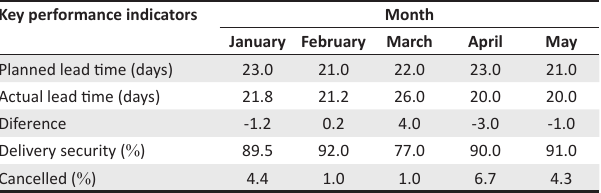
TABLE 3: Details for calculation of logistic key performance indicators. Key performance